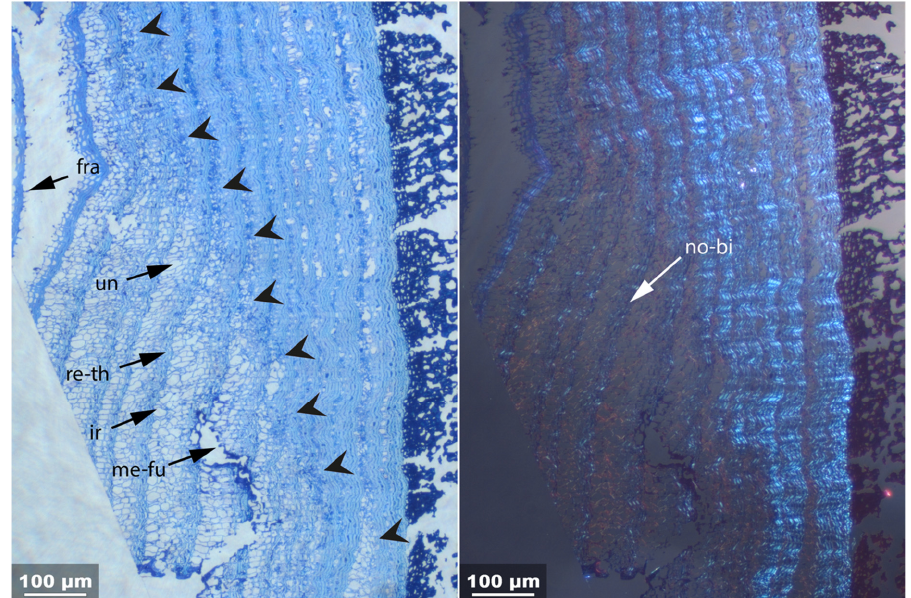
increased irregularity of cell arrangement (ir) and reduction of cell wall substance, especially suberized secondary wall of